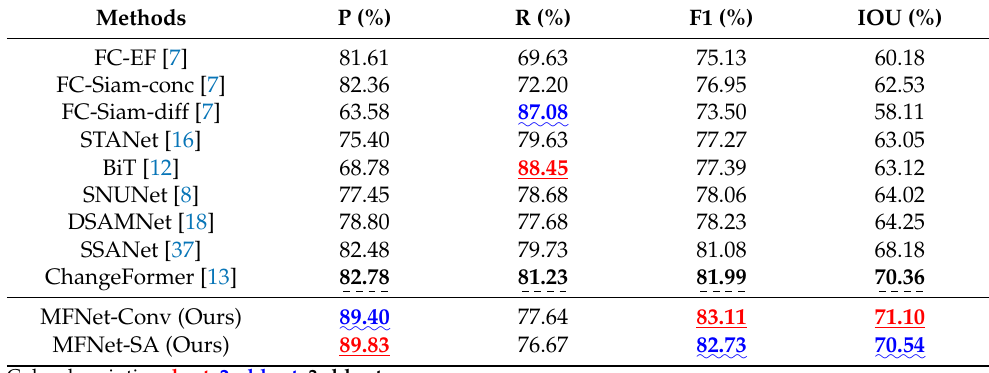
Table 3. Quantitative evaluation results of different algorithms on SYSU-CD.